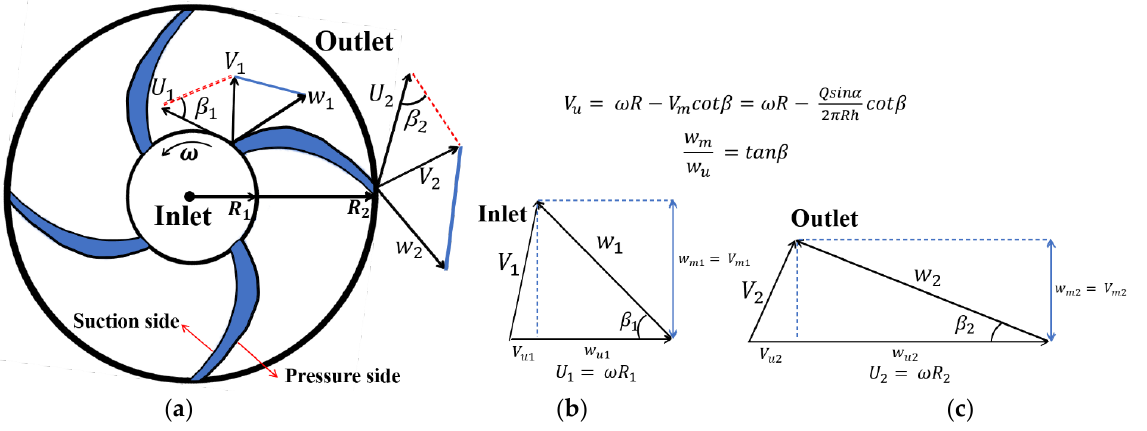
Figure 4. Flow mechanism representation by velocity triangle. ( a ) Flow velocity diagram of the impeller having four blades; ( b ) velocity triangle at an inlet; ( c ) velocity triangle at an outlet.